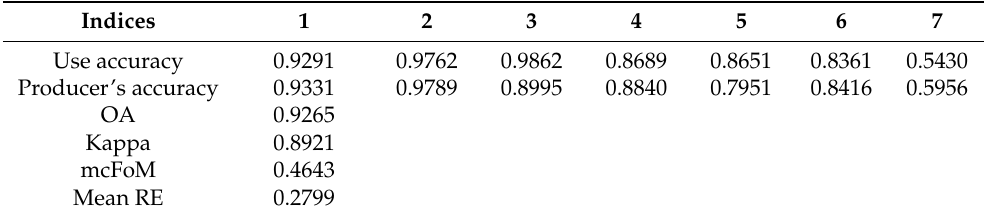
Table 6. Accuracy indices of the mixed-cell CA model for the experiment.